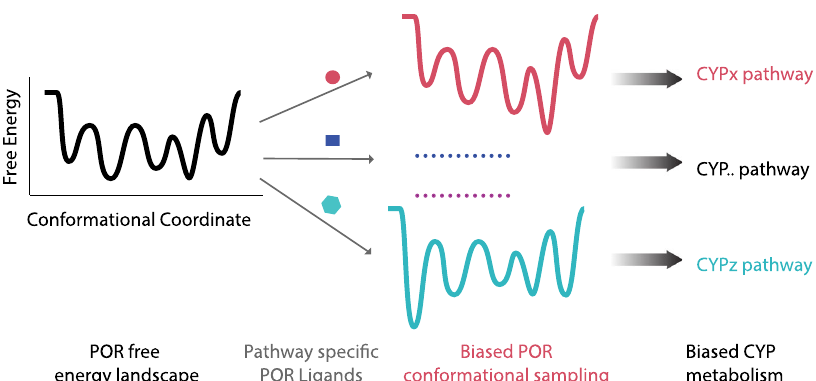
Fig. 6 Cartoon representation of the concept of biased metabolism a mechanism akin to biased signaling of GPCRs but for metabolic hubs. Ligand binding on POR appears to remodel its energy landscape, alter its conformational sampling consequently biasing downstream CYP activation by inhibiting the activation of a subset of CYPs and/or enhancing the activation of others. Targeting POR may act as a hitherto unknown paradigm for metabolic control in human and plants. Complete understanding of biased metabolism may offer the in silico design of pathways speci fi c pharmaceutics or personalized food suppressing undesired, disease related,